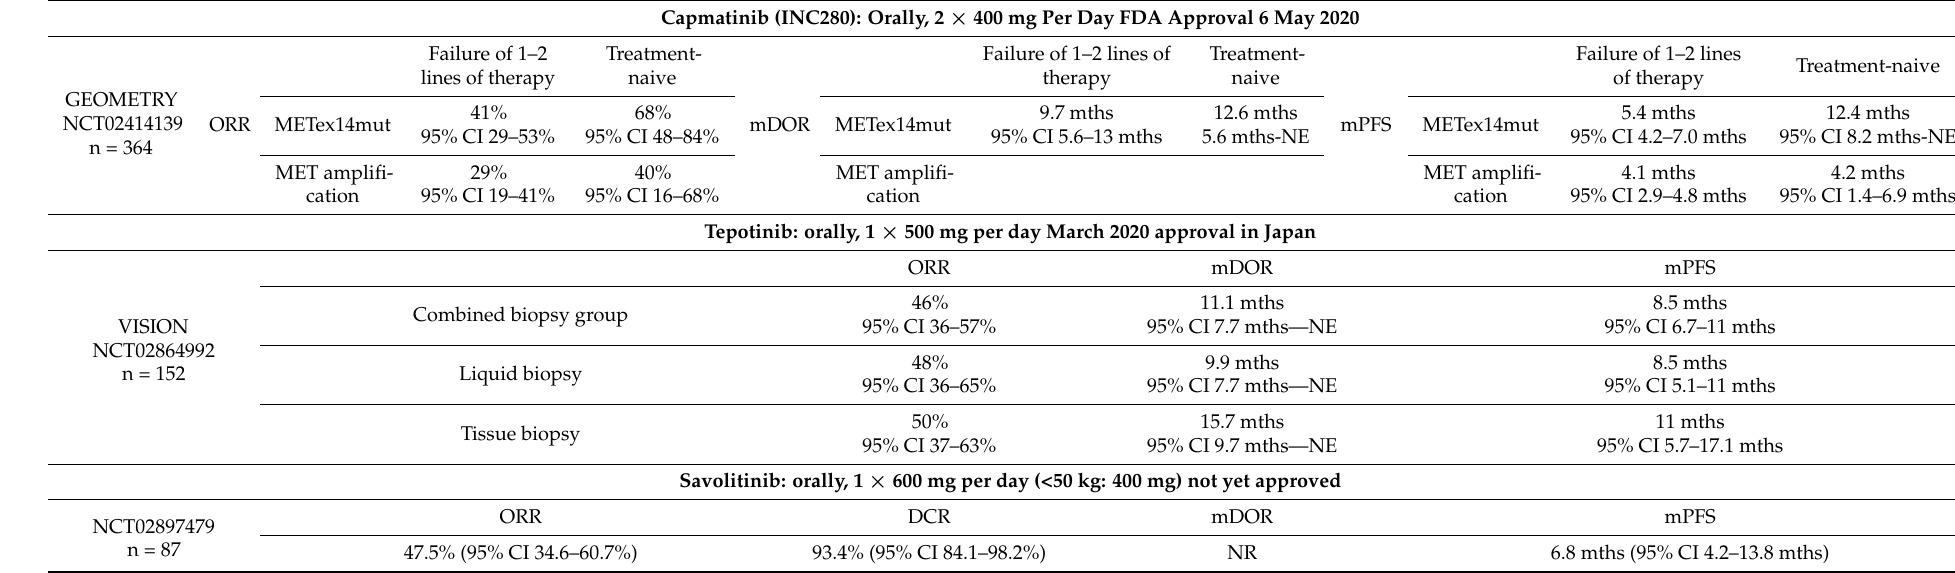
Table 1. Detailed results of mesenchymal epithelial transition (MET) tyrosine kinase inhibitor (TKI) efficacy. Abbreviations: DCR, disease control rate; mDOR, median duration of response; ORR, overall response rate; mPFS, median progression-free